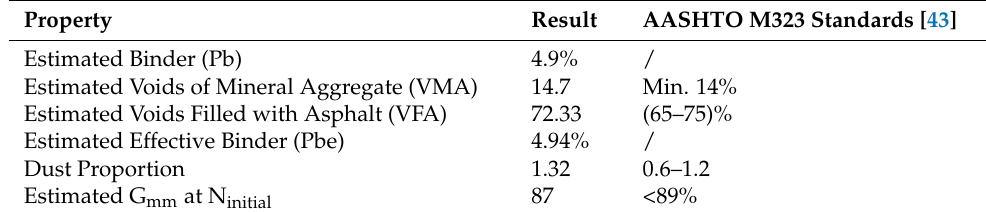
Table 14. The estimated volumetric properties of the